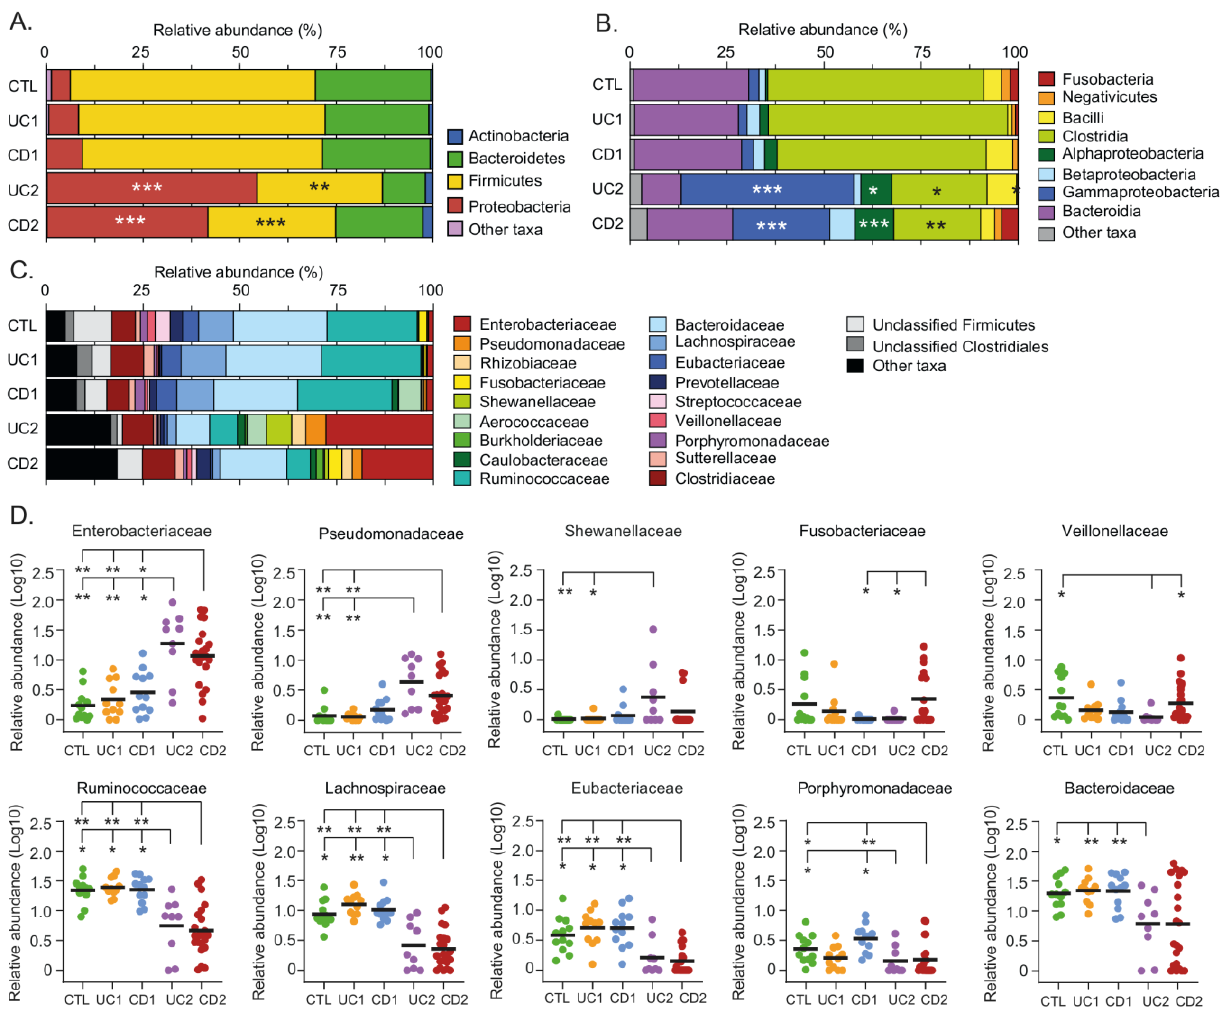
FIGURE 3: Phylogenetic composition of bacterial taxa at the phylum, class, and family level among IBD patients and non-IBD controls. Relative abundances (%) of common bacterial taxa (> 1% abundance) at phylum (A) , class (B) , and family (C) levels. (D) For a better analysis and visualization, comparisons in the relative abundances at the family level between groups were performed using Log-transformed values. Each data point corresponds to a sample and horizontal lines to the means. Only taxa in which significant differences were found are shown. Significance: * p < 0.05, ** p < 0.005, *** p < 0.0005, Kruskal- Wallis & Dunn’s